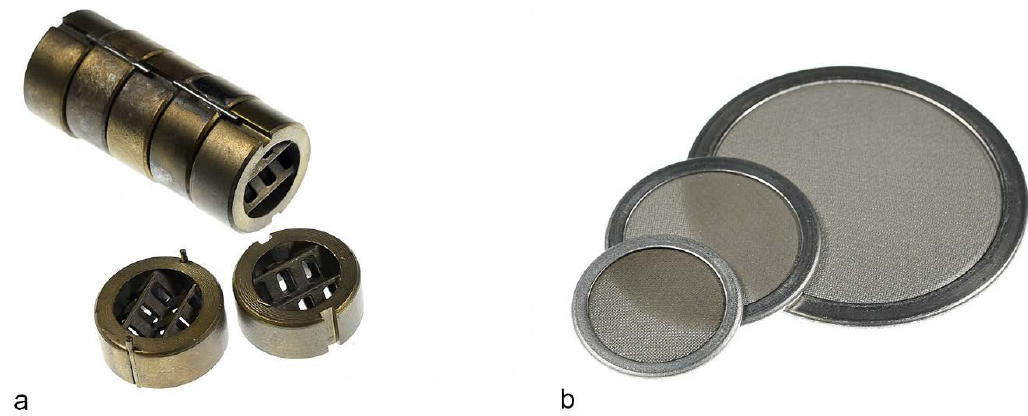
Figure 3. Examples of static mixers ( a ) and stainless steel filters ( b ).